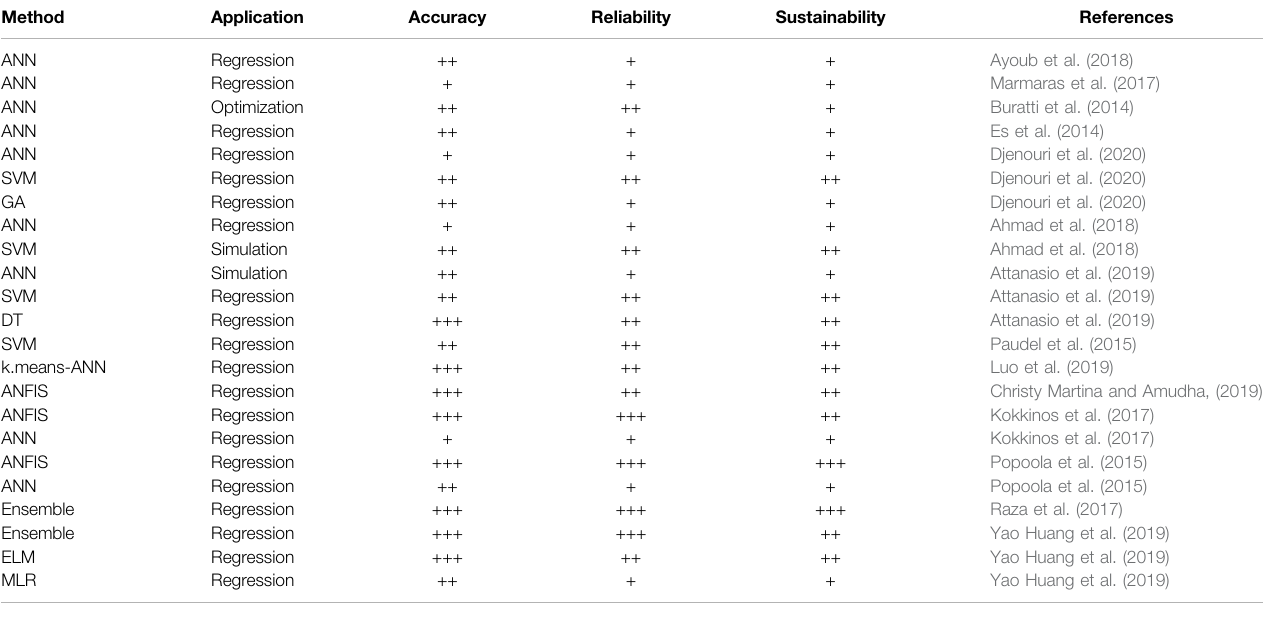
TABLE 3 | The comparison fi ndings of techniques for BE demand.